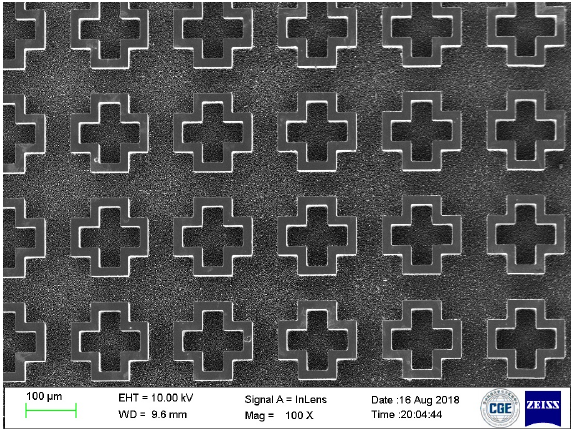
Figure 6. SEM image of the fabricated THz